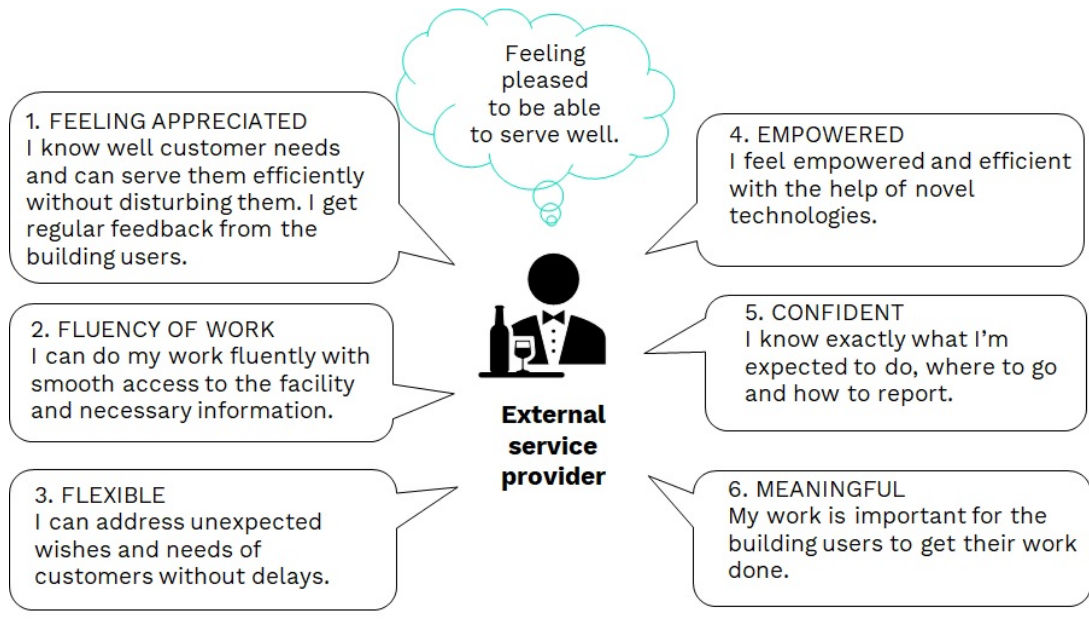
Figure 6. The UX vision and UX goals for external service providers.